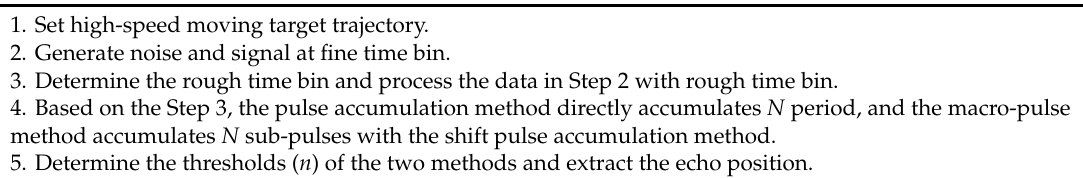
Table 2. The simulation